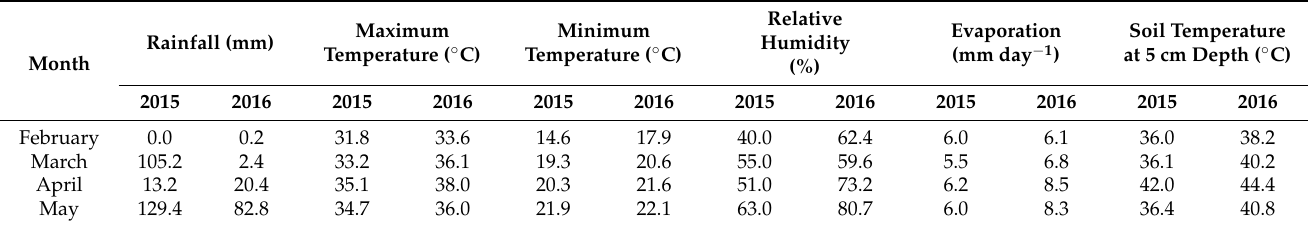
Table 7. Average seasonal rainfall, maximum and minimum air temperatures, relative humidity, evaporation, and soil temperature of the experimental site at Dharwad in 2015 and